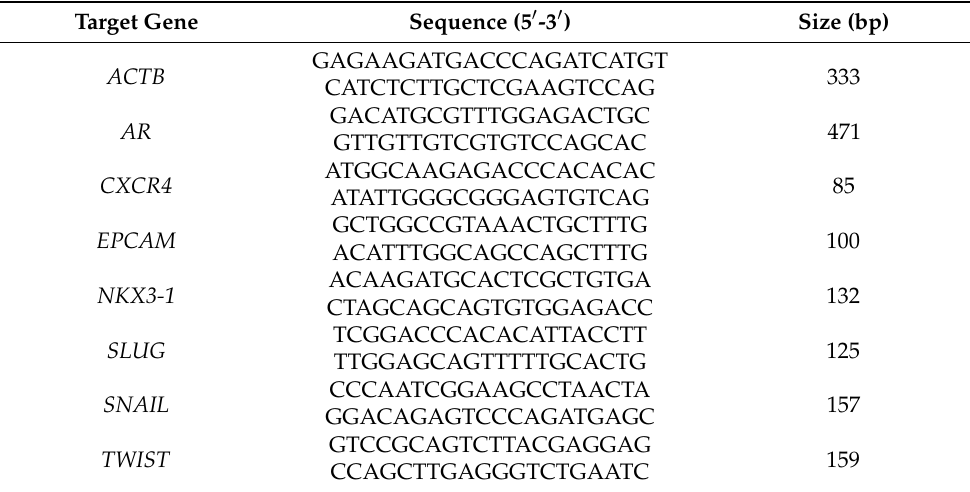
Table 3. Primer sequences used for gene amplification via reverse-transcription polymerase chain